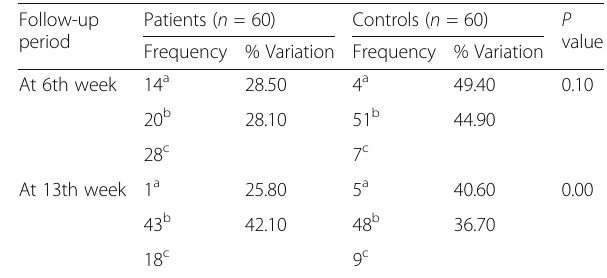
Table 3 Percentage variations in weight of participants at the 6th and 13th week Follow-up period